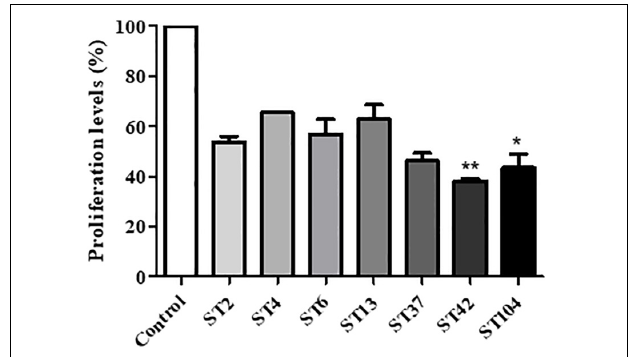
FIGURE 3 | Effect of different sequence type (ST) strains on Vero cells’ proliferation. Vero cells were treated with different ST’s toxins for 24 h. Then, cell proliferation was measured using the XTT assay. n = 3 (three different isolates were used for each ST). * p < 0.05 vs. control cells, ** p < 0.01 vs. control cells.